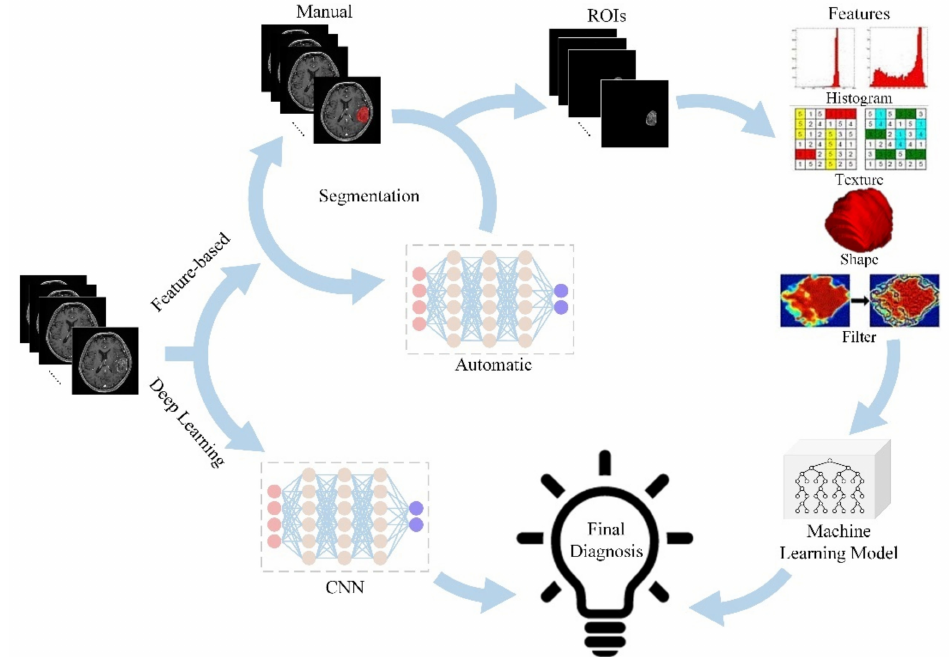
Figure 1. General framework showing the main steps of the